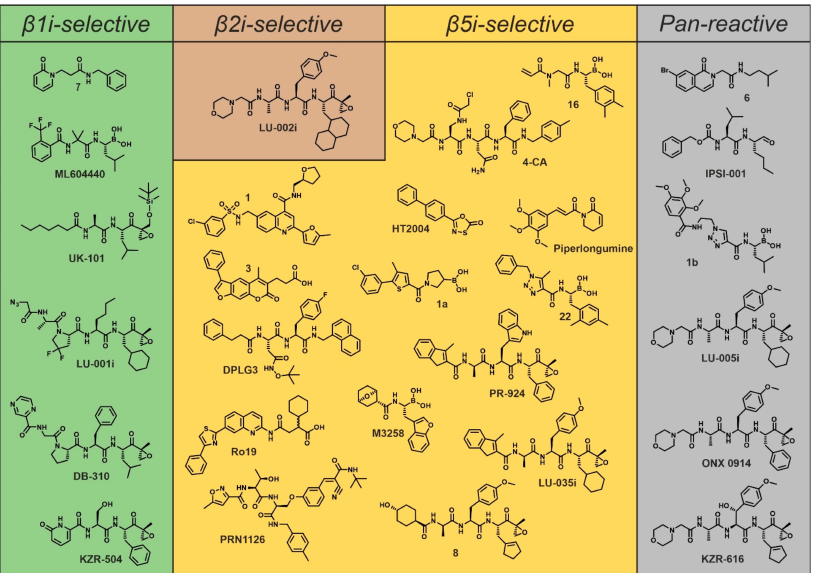
Figure 3. Chemical structures of non-covalently and covalently acting iCP inhibitors. Compounds are grouped and colored according to their subunit selectivity and arranged according to their discussion in the text. The original compound numbering from patents or publications was taken over wherever possible (for references see Table 1). To avoid duplicates, compounds 1a and 1b were given a letter in addition. For inhibition values see Table 1. Due to space limitations, only selected compounds of each class are